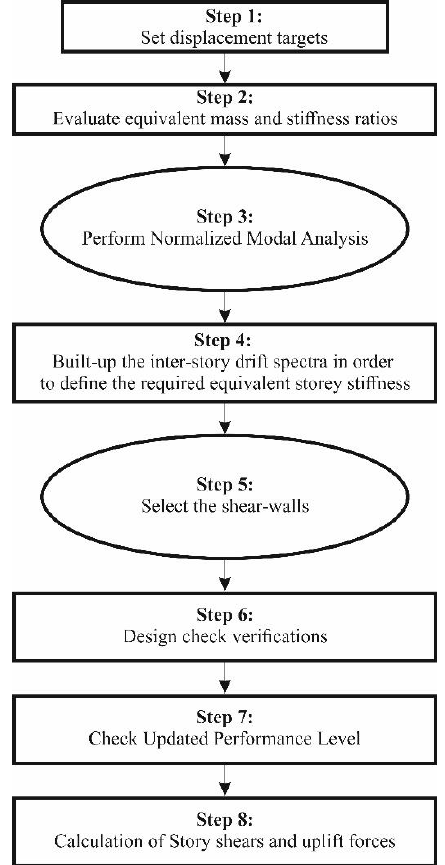
Figure 1. General flowchart for the application of the Modal-Displacement-Based Design (DBD) procedure to multi-story buildings.